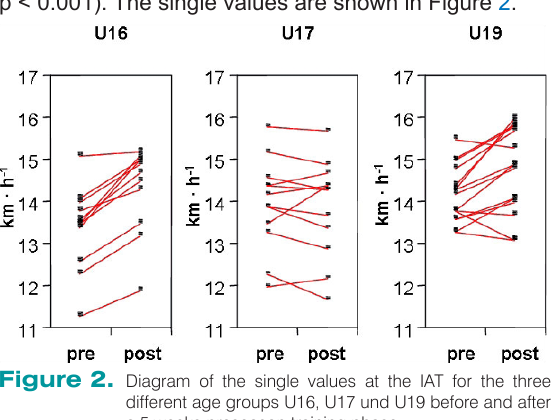
Figure 2. Diagram of the single values at the IAT for the three different age groups U16, U17 und U19 before and after a 5 weeks preseason training